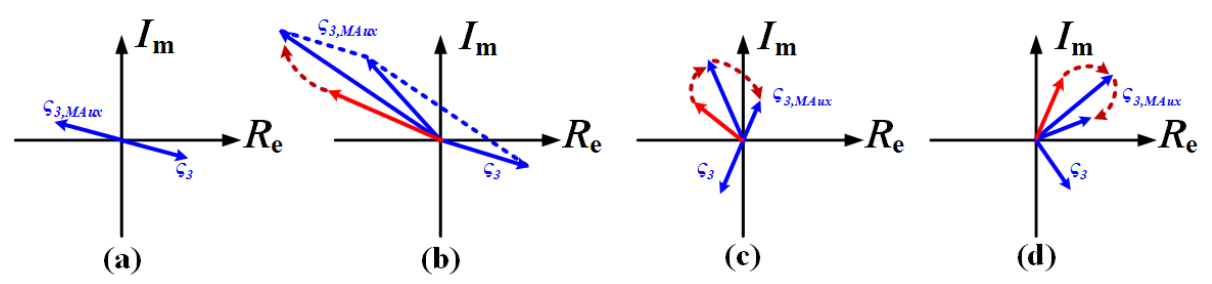
Figure 13. ( a ) Conceptual nonlinear cancellation mechanism; ( b ) ς 3 and ς 3, MAux vector diagram as L sa increases in a low frequency range; ( c ) ς 3 and ς 3, MAux vector diagram as L sa increase at medium frequency range; ( d ) ς 3 and ς 3, MAux vector diagram as L sa increases in the high frequency range.